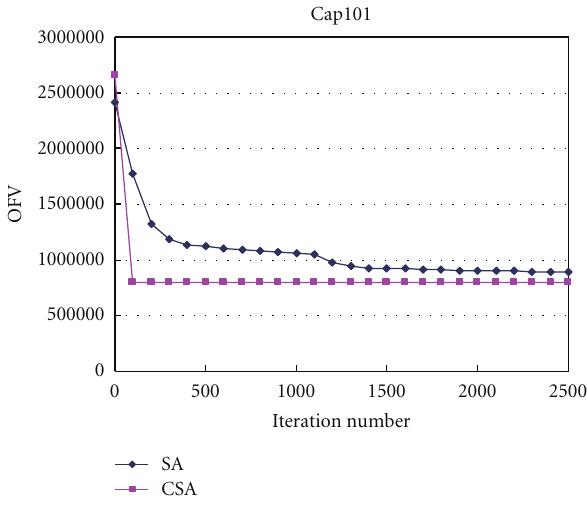
Figure 1: OFV versus iteration number in Cap101. Figure 2: OFV versus iteration number in